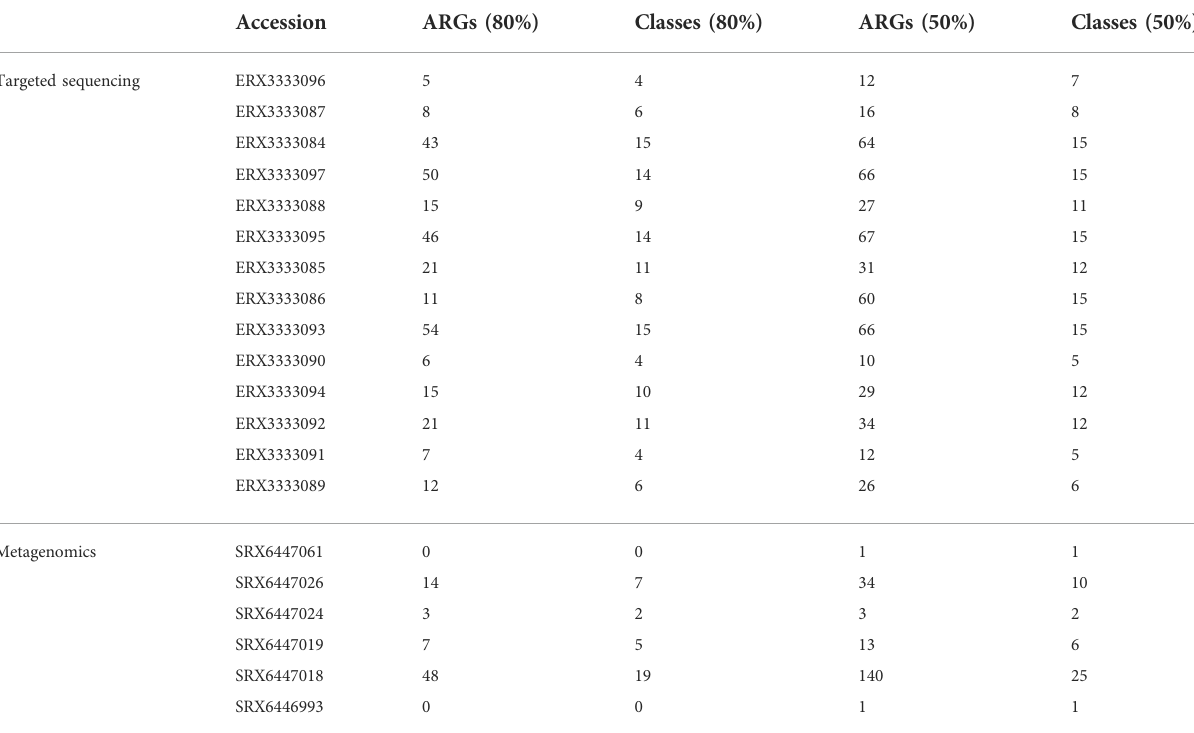
TABLE 3 Distribution of ARG fi ndings by KARGAMobile using gene coverage thresholds of 80% and 50%, counting the number of different ARGs and ARG classes, on real experimental data: (1) targeted sequencing of C. cronae , C. freundii , and P. aeruginosa in hospital outbreaks; (2) metagenomics experiments from mechanically-ventilated patients hospitalized with severe